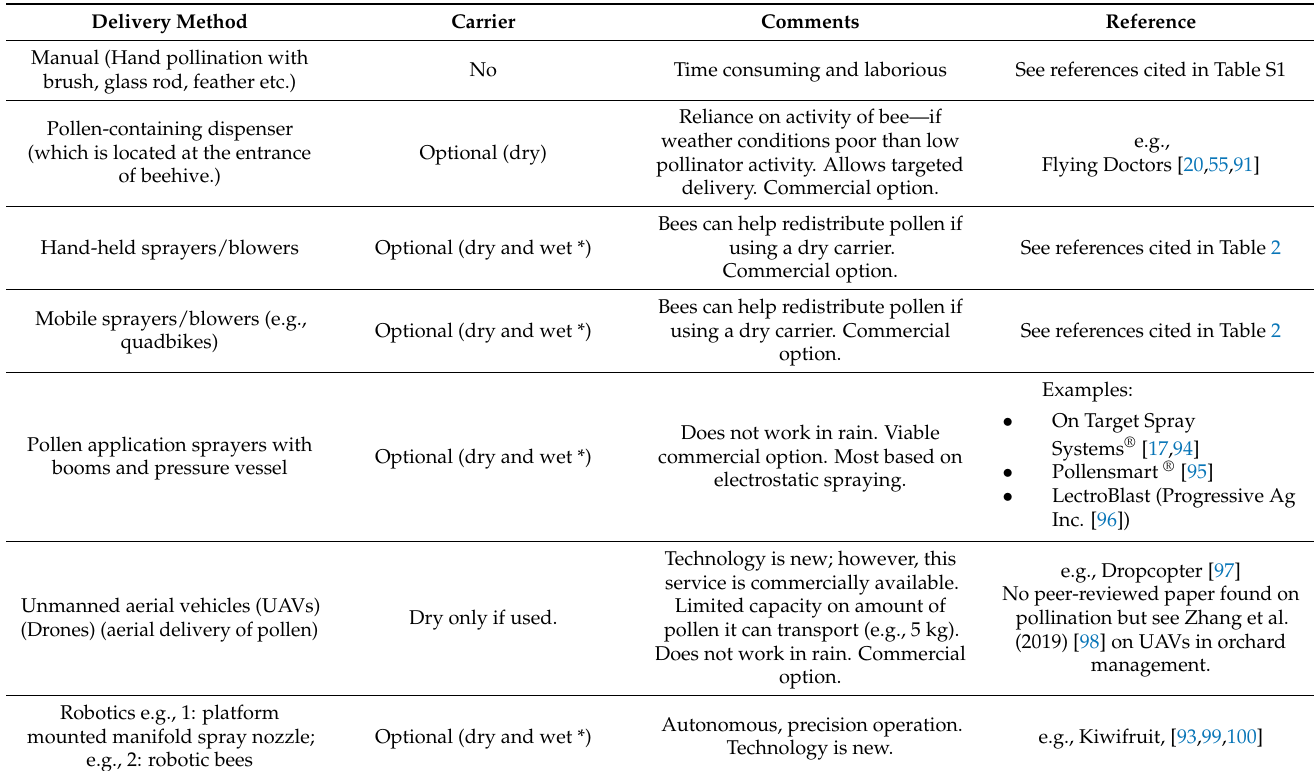
Table 3. Summary of pollen delivery options (from the simple to the more complicated designs). * Once mixed in wet carrier, pollen viability is limited to 100 min (Whiting